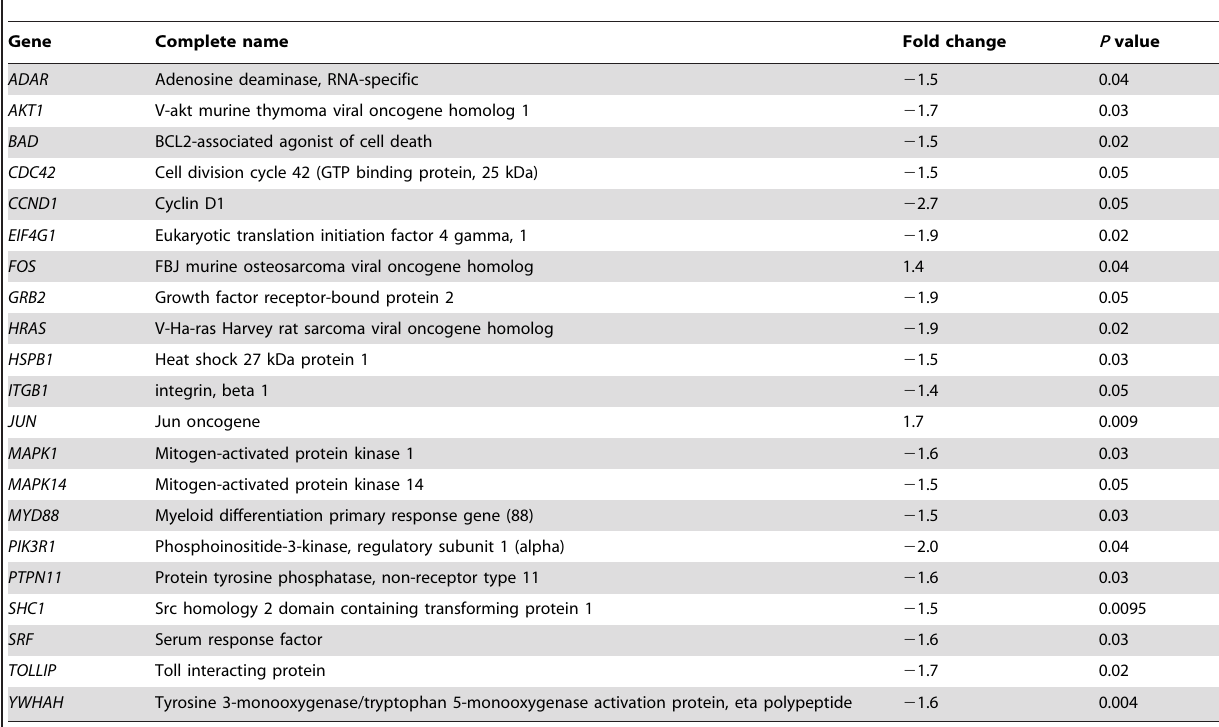
Table 2. In vitro effects of 0.5 mg/mL Reishi on the expression of PI3K/AKT/mTOR pathway genes.